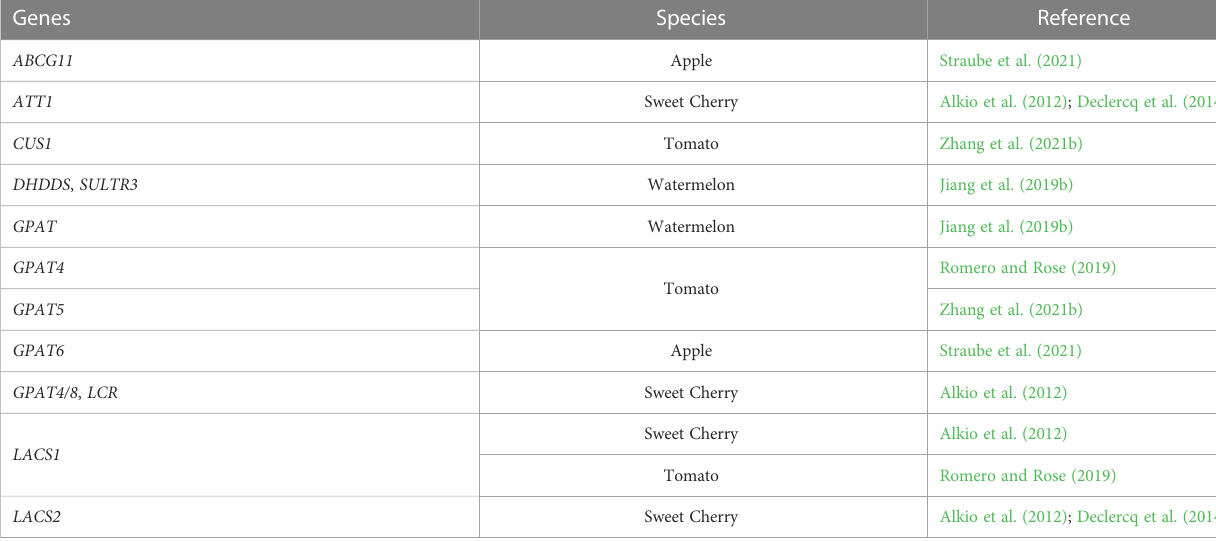
TABLE 2 Potentially cracking-related genes involved in cutin biosynthesis and deposition.